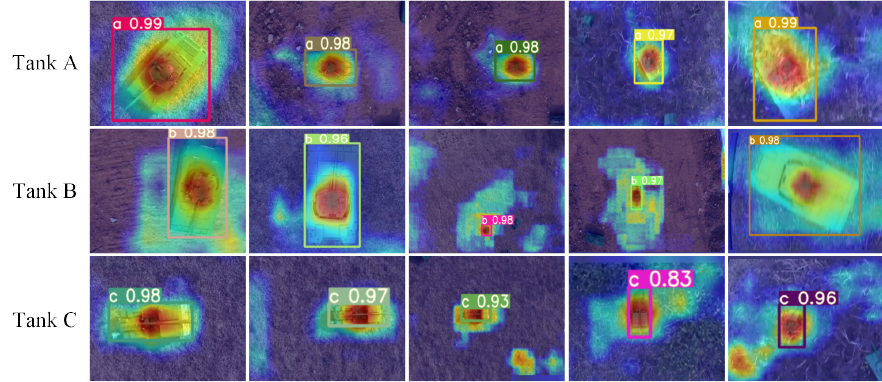
Figure 13. Class Activation Maps from UAVT-YOLOv5.